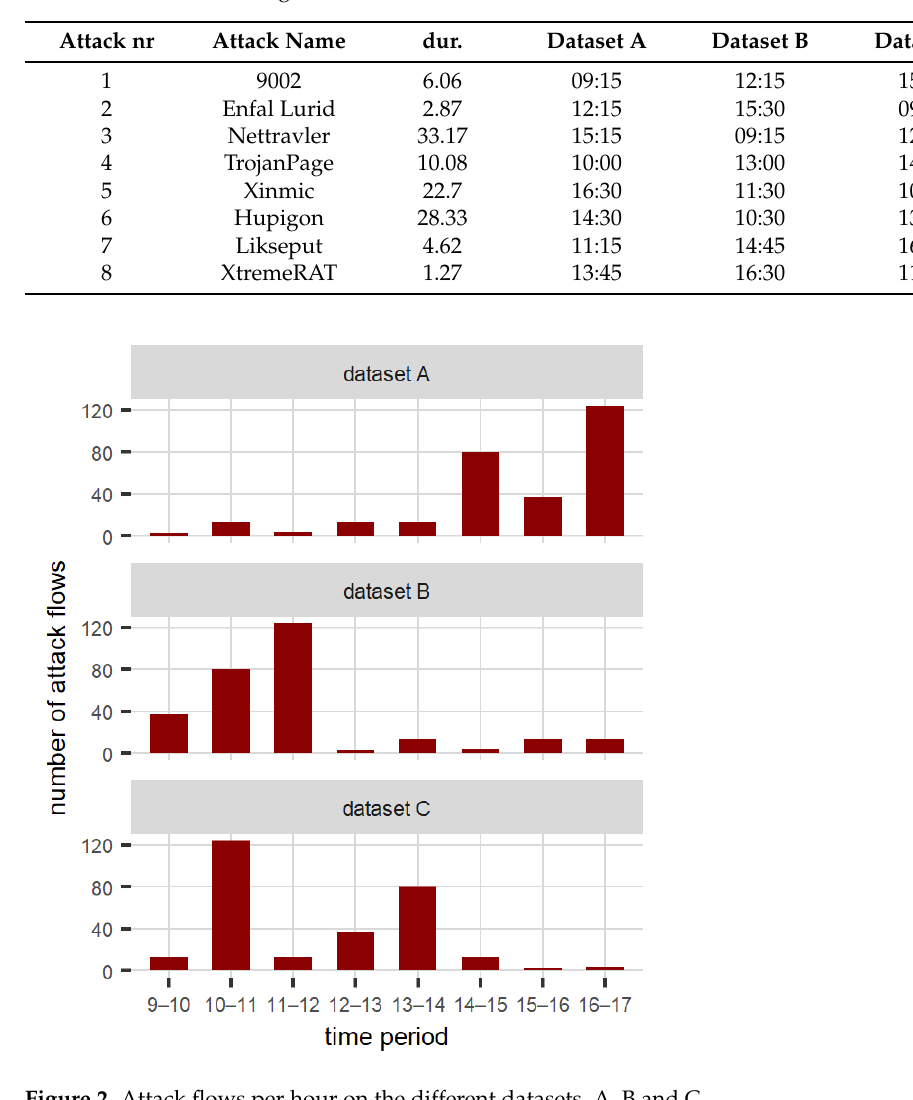
Figure 2. Attack flows per hour on the different datasets, A, B and C.